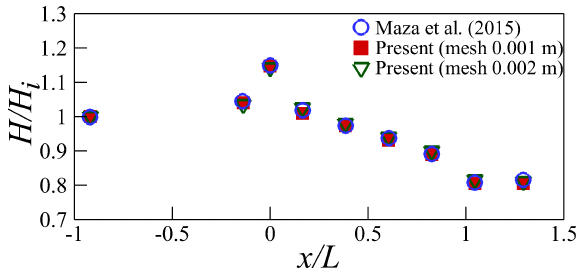
Figure 6. Comparison of wave height evolutions for moving cylin- ders with different spring constants.